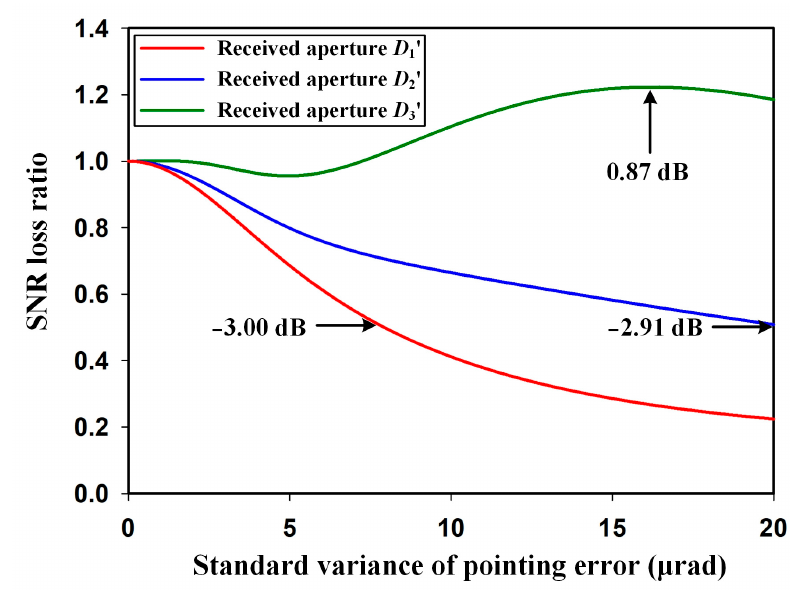
Figure 11. SNR loss ratio with the increase in pointing error.